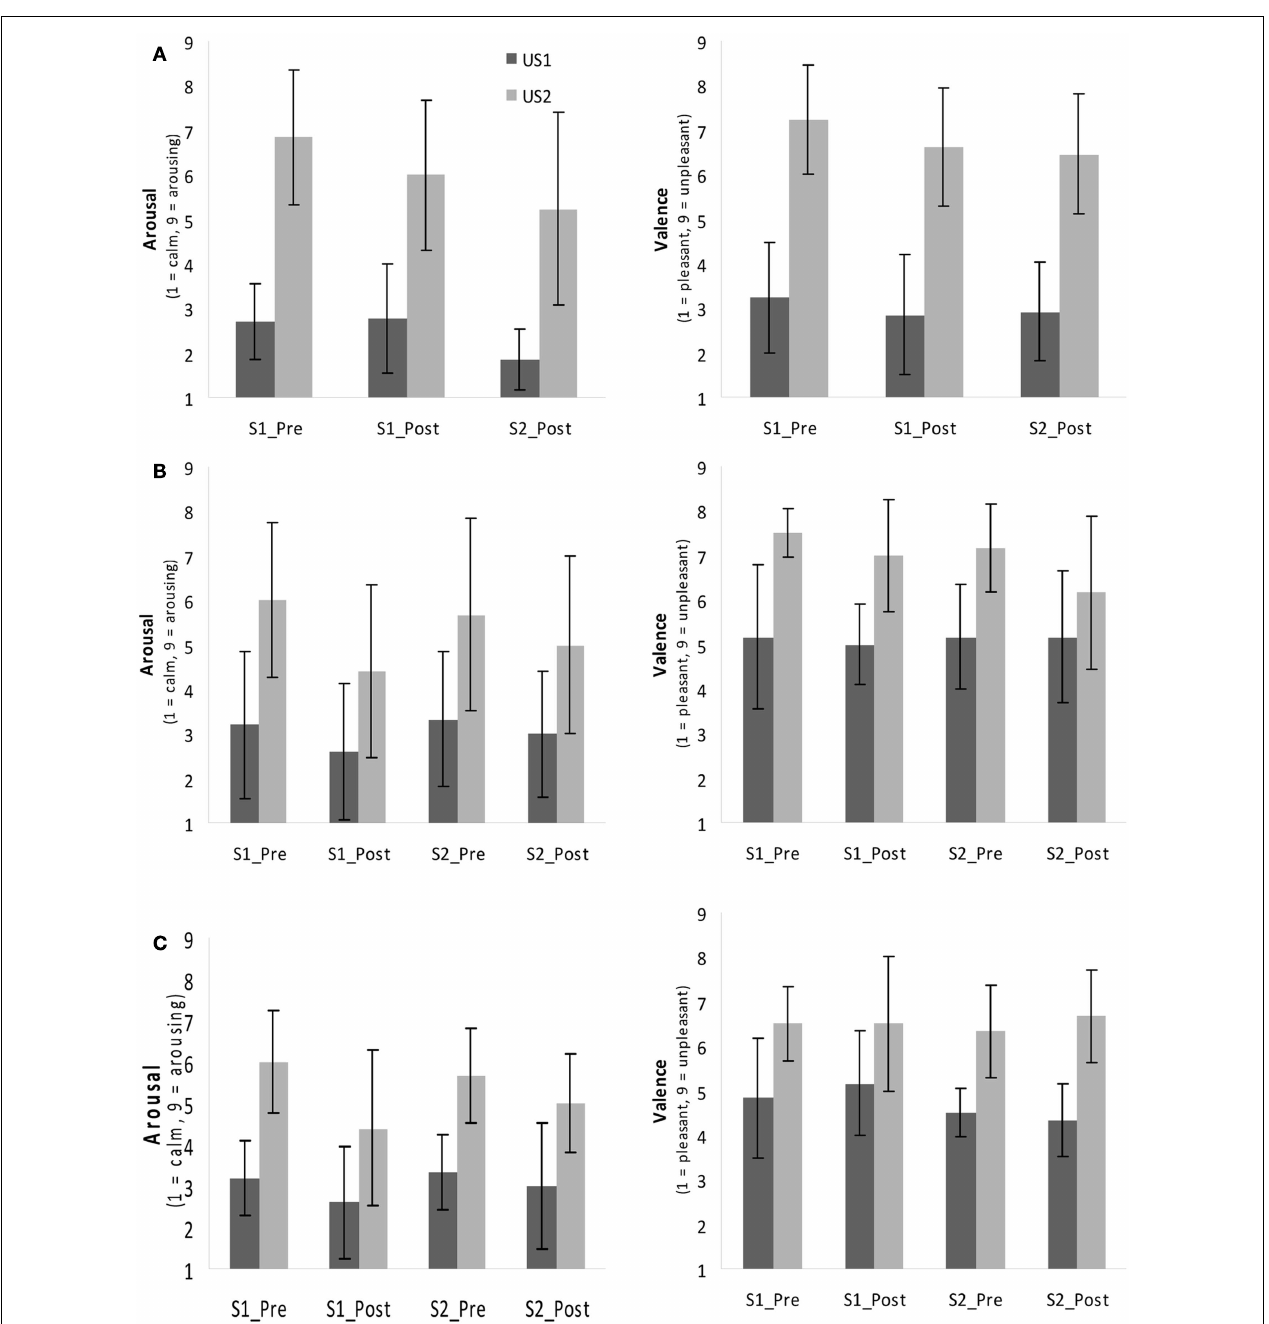
FIGURE 2 | Rating of valence and arousal (Self-Assessment Manikin, SAM) in Exp I (A) and Exp II for Group 1 (B) and Group 2 (C) before (“Pre”) and after (“Post”) both sessions (S1, S2). S1, session 1, S2, session 2.